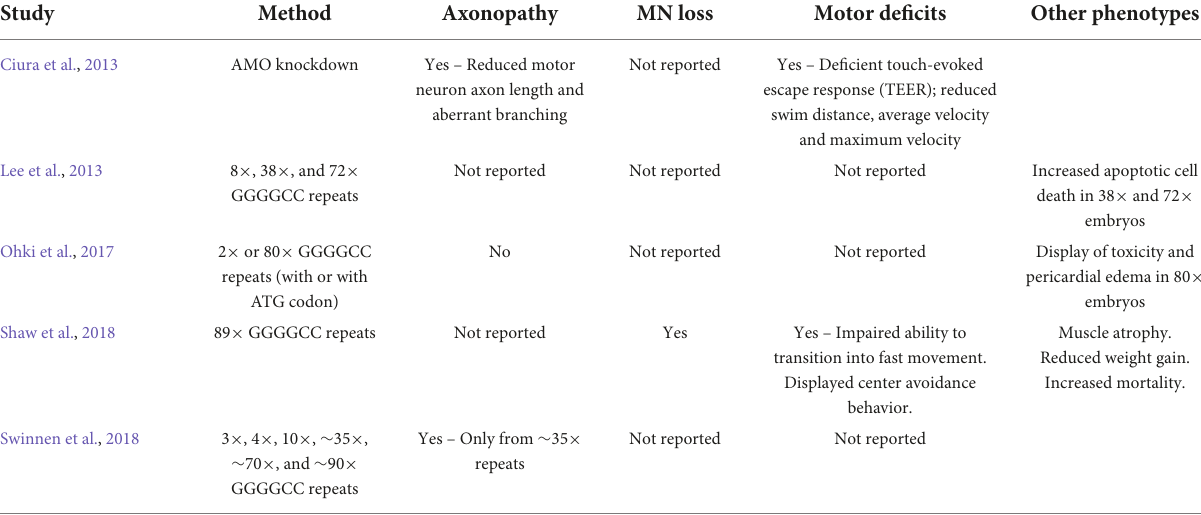
TABLE 8 Zebrafish models of C9orf72